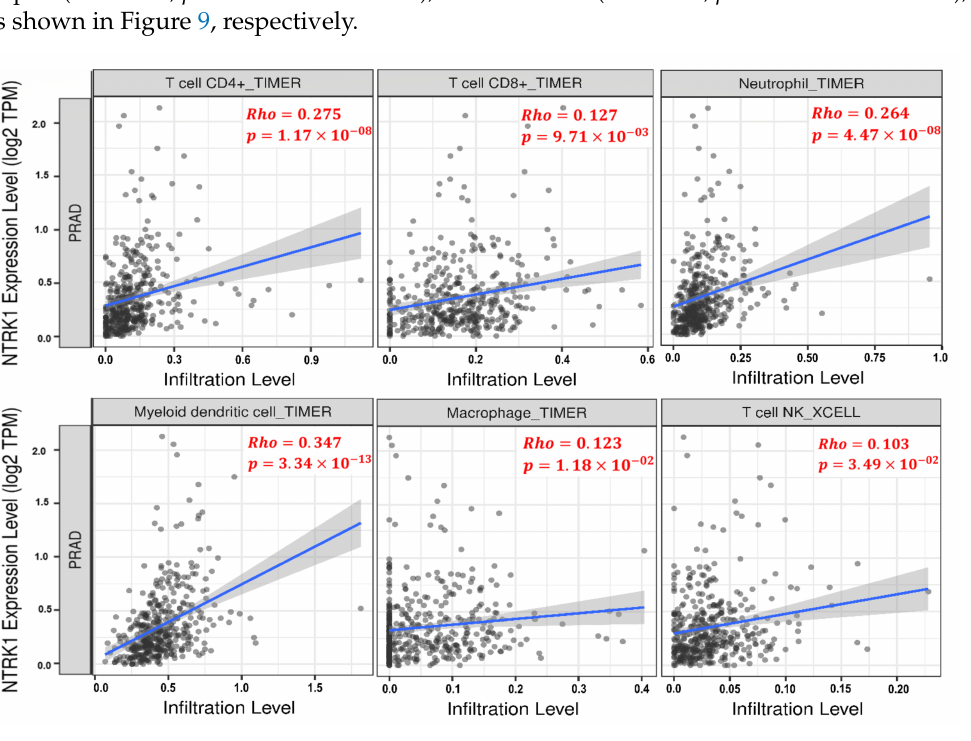
Figure 9. The scatter plots exhibiting significant positive correlations of NTRK1 with the